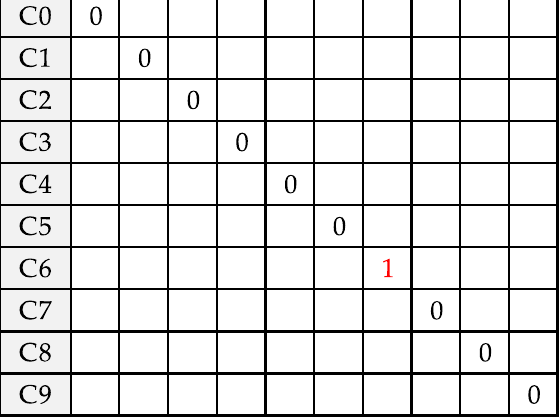
Figure 9. Inference result showing the recognition of the digit “6” drawn by the user (accuracy = 100.00%, root ‐ mean ‐ square error (rmse)= 0.0000, medium average error (mae) = 0.0000, 10 classes, 1 sample).